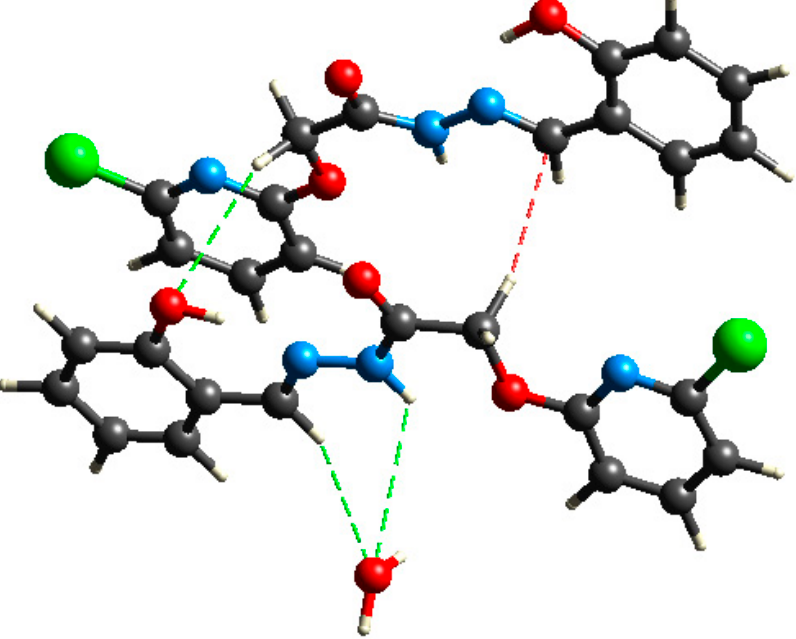
Figure 8. Hydrogen bonds in HBPAH.